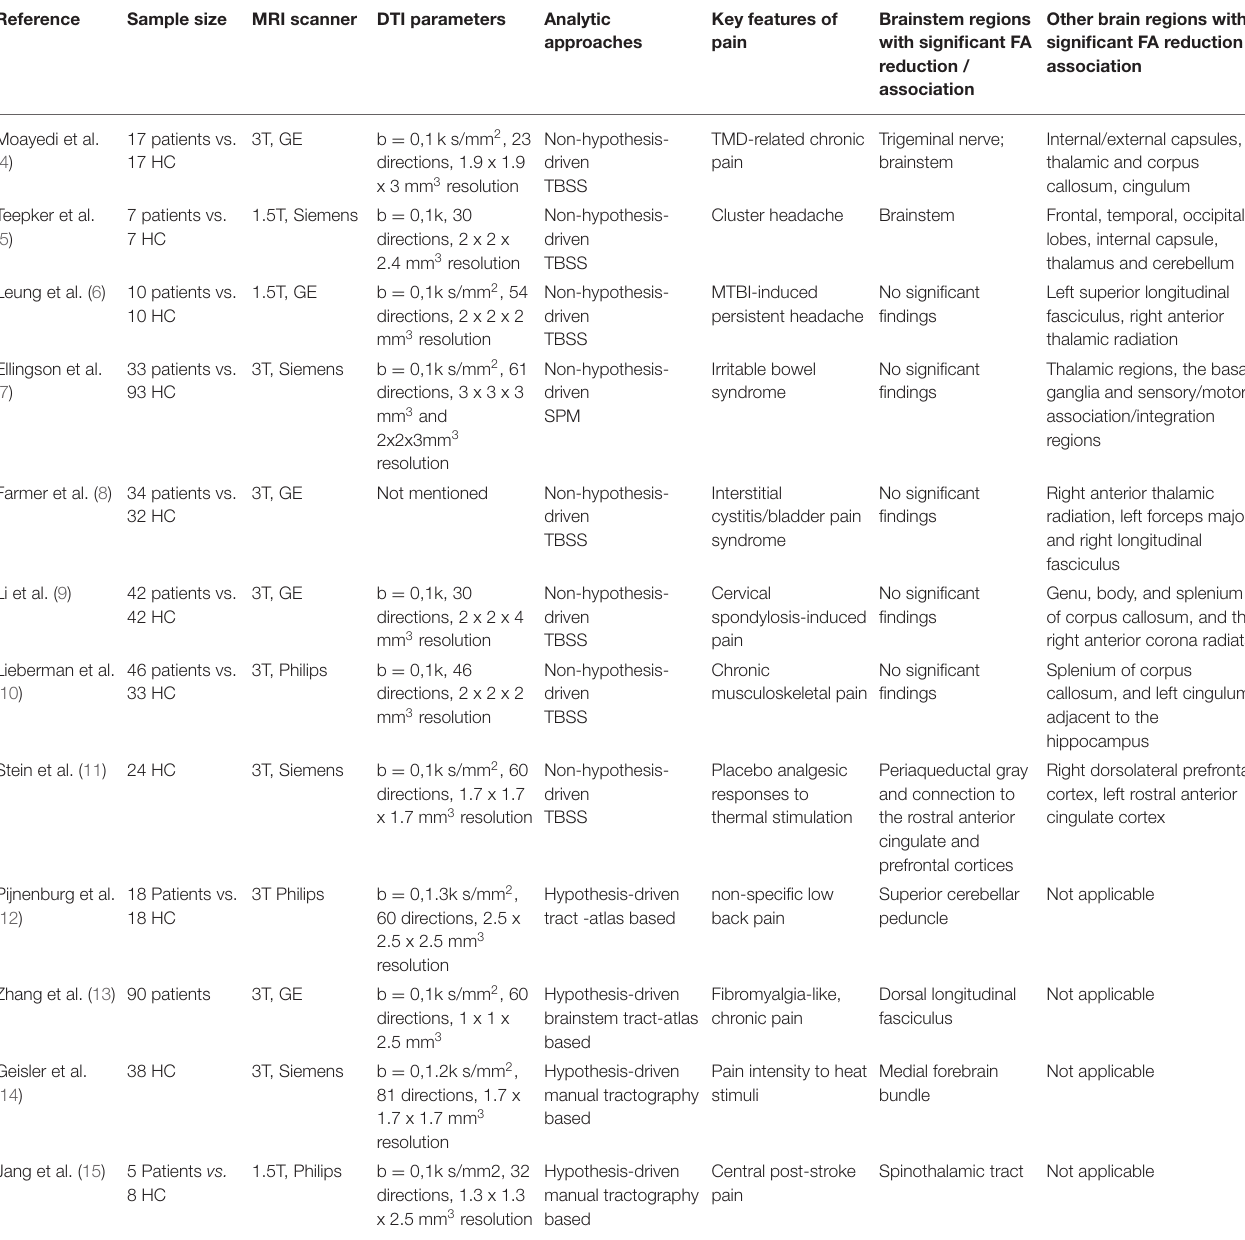
TABLE 1 | Technical details and major findings of the DTI application studies (voxel-based, as well as tract-based) in pain.